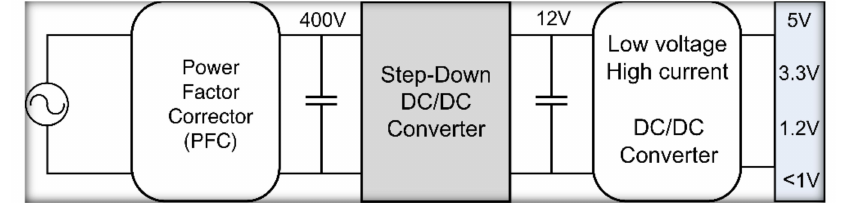
Figure 1. Distributed power conversion